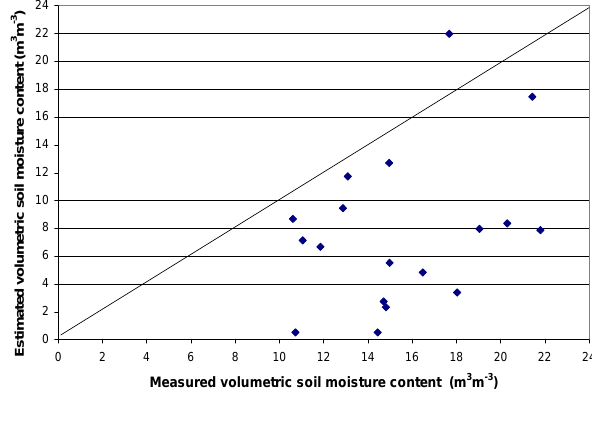
Fig. 5. Scatter plot of volumetric soil moisture contentmeasured and estimated by GOM.